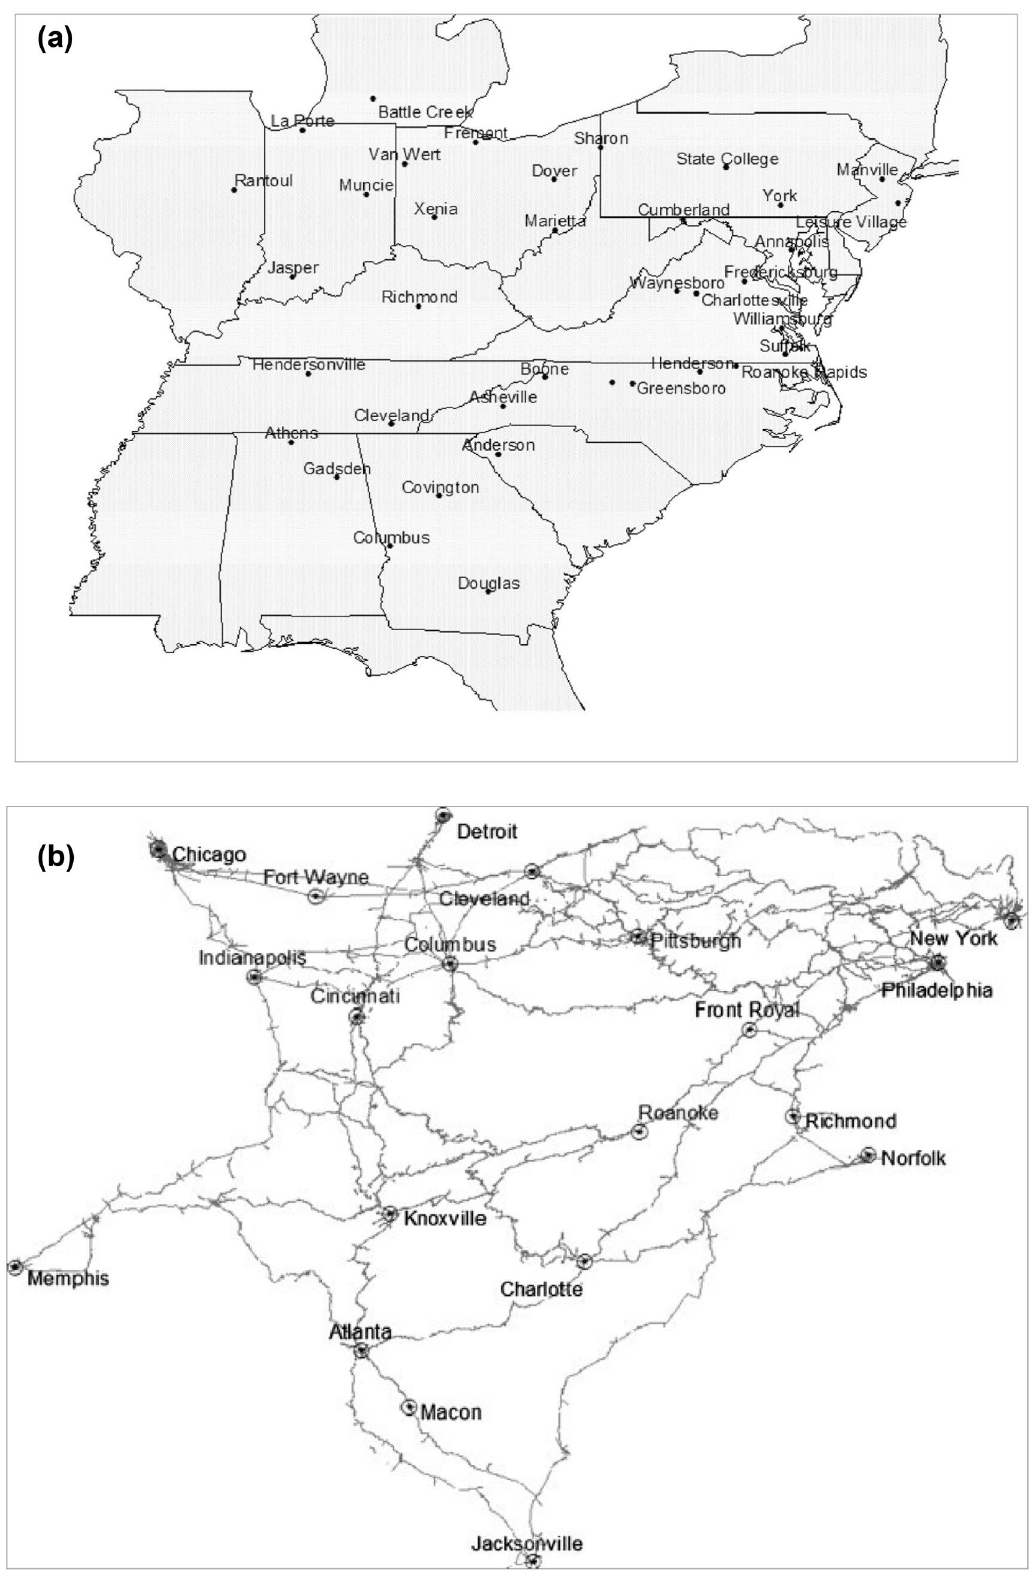
Fig. 6 a Shipper/receiver locations. b Intermodal terminals and